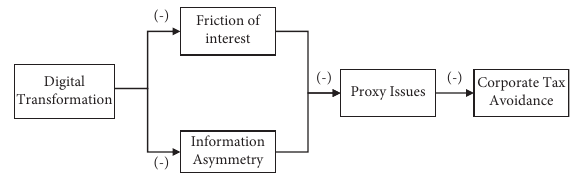
Figure 1: Mechanisms of digital transformation on corporate tax